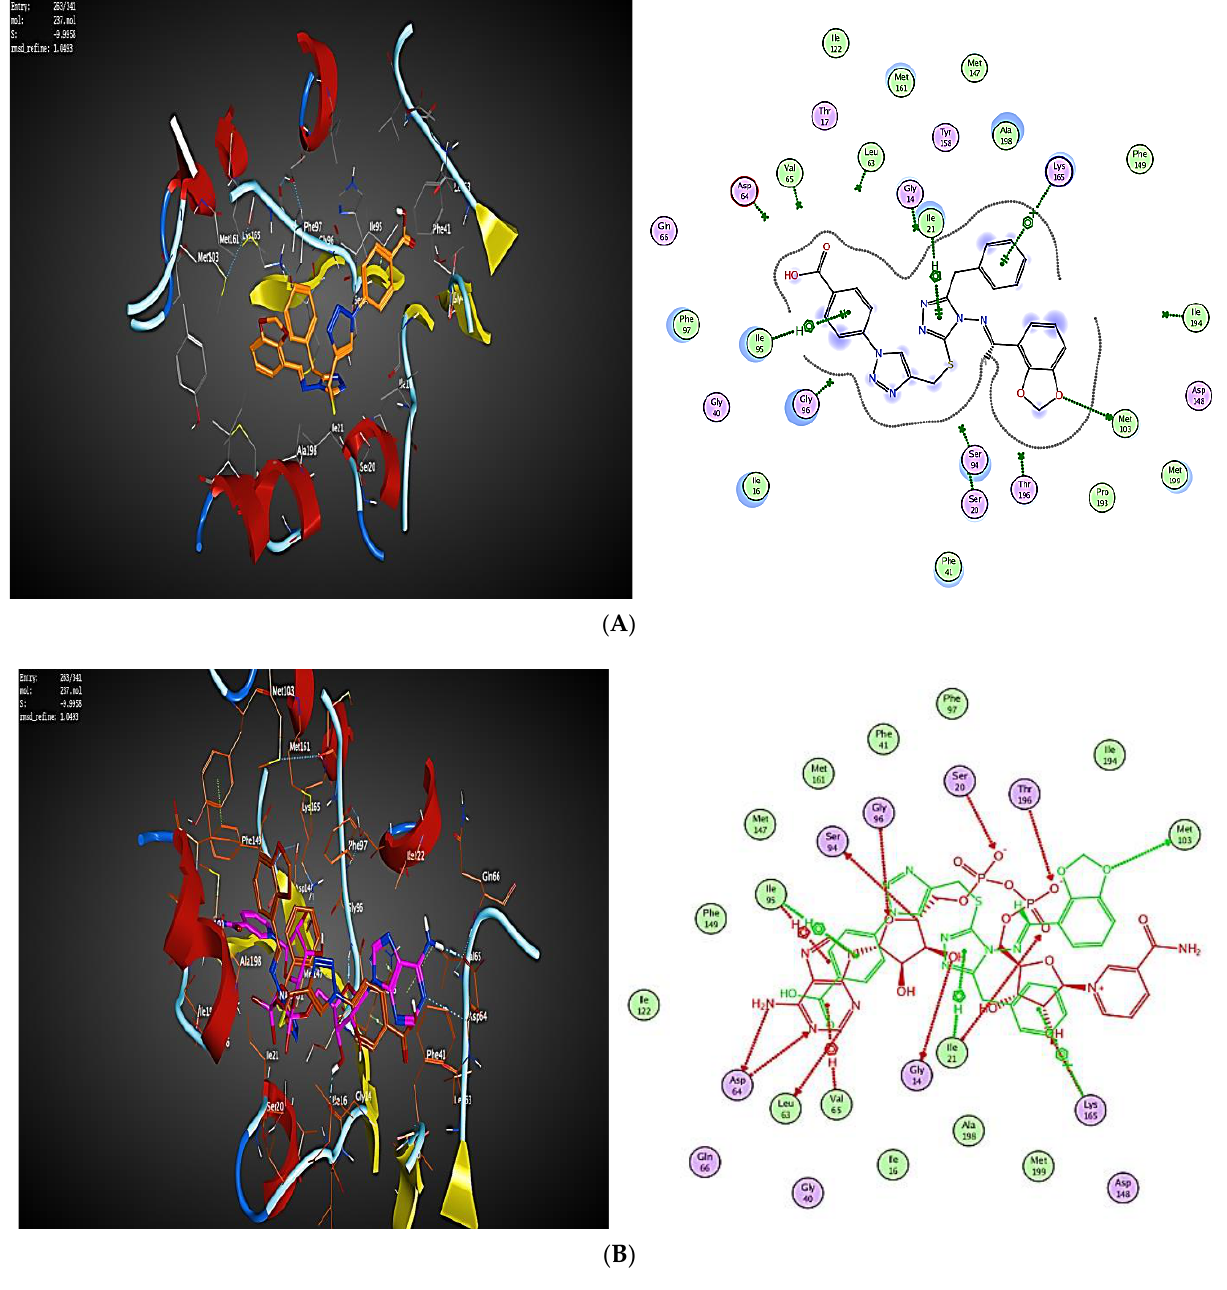
Figure 6. ( A ): Docking and binding pattern of compound 7c into inhA active site (PDB ID: 4TRO) in 2D (right panel) and 3D (left panel). ( B ): An overlay of the docked pose of compound 7c (brown) with the co-crystallized ligand (purple) into inhA active site in 2D (right panel) and 3D (left panel). Molecular docking studies of the target compound 7e displayed (S) − 11.7 kcal/mol and (RMSD) of 1.29 revealed that the 4-morpholino ring oxygen forms a hydrogen bond of 3.34 Å with Val65. Furthermore, 1,2,3 triazol-1-yl benzoic acid forms a hydrogen bond of 3.10 Å with Ile194 along the same track, 3-thio atom part in the linker forms a hydro- gen bond of 3.70 Å with Ser94. Besides, 2 Hydrophobic π -H bond interactions were en- countered between 1,2,4 triazole and 4-benzylidene ring of 3.79 and 4.89 Å with Gly96 and Ser20, respectively (Figure 7A,B). ( A )